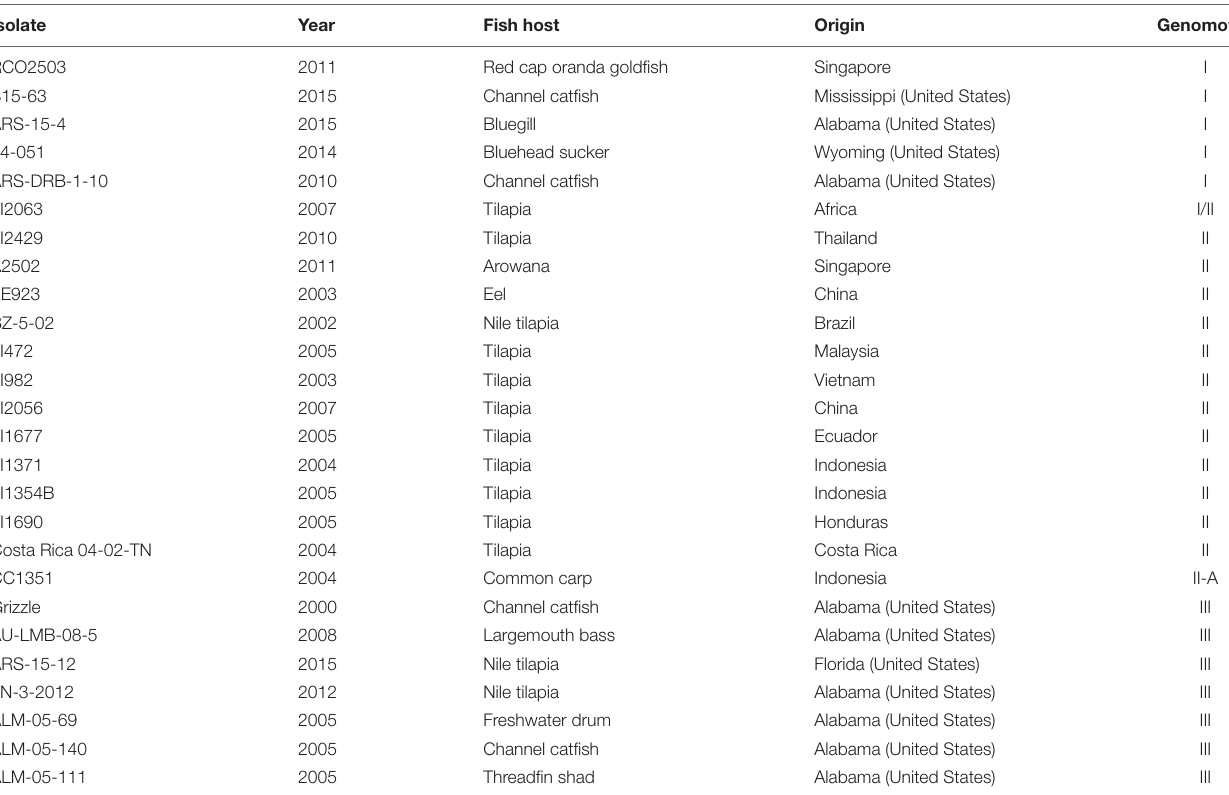
TABLE 2 | Description of Flavobacterium columnare isolates used in this study, including the year and fish host of isolation, geographic origin, and genomovar assignment.